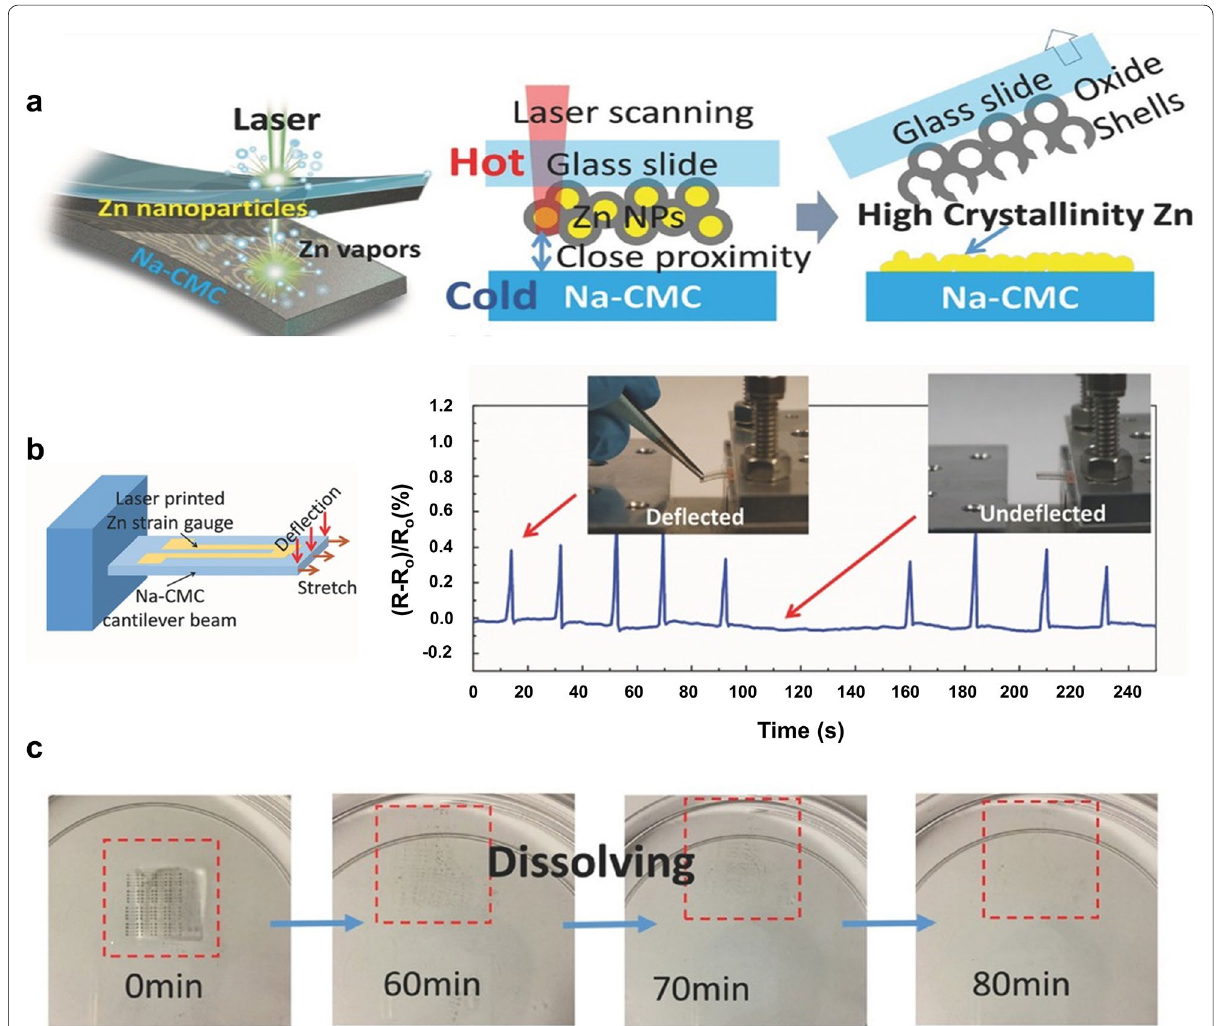
Fig. 4 a Technical illustration and schematics of the laser printing process to generate Zn electrodes on Na-CMC. b Schematic of the laser-printed resistive Zn strain gauge. Response of the strain gauge under deflection. c Photograph of the dissolution process of Zn patterns on the Na-CMC substrate in distilled water ( a – c reproduced with permission from Ref. [55]. Copyright Wiley–VCH